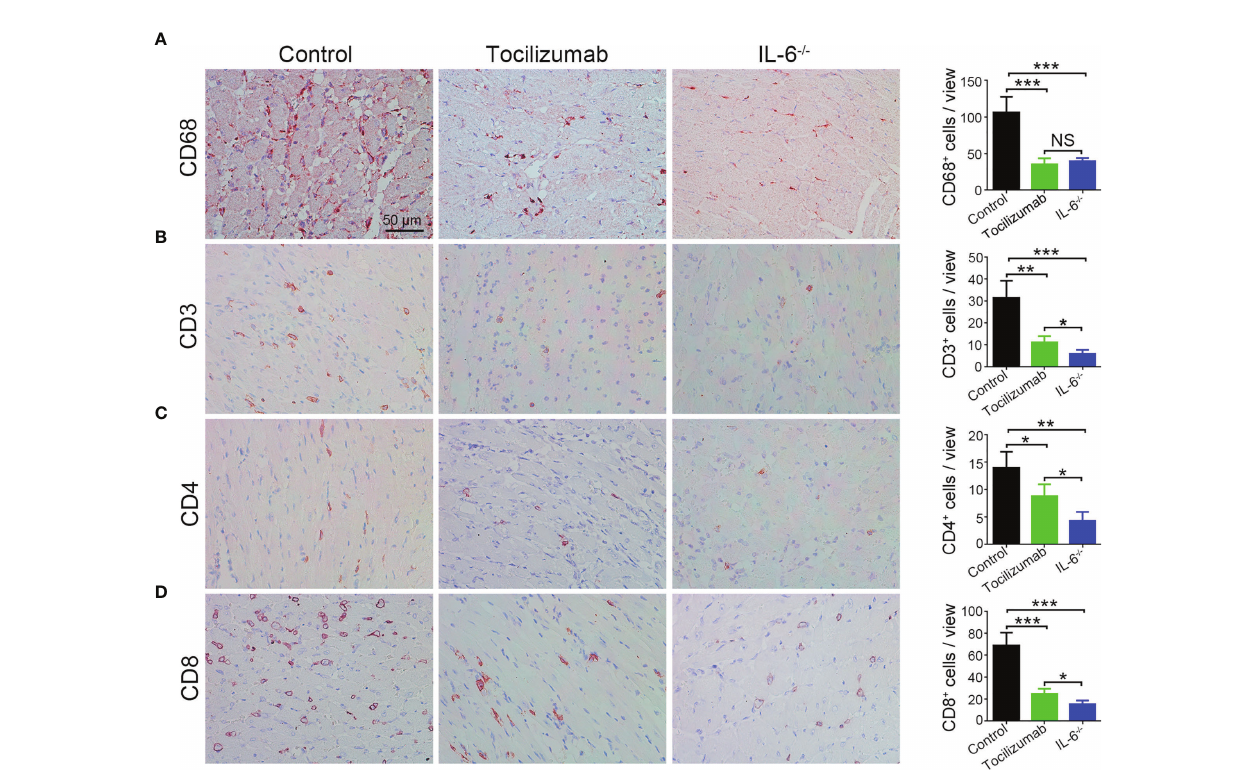
FIGURE 6 | Blockade of IL-6/IL-6R signaling reduces macrophages and T cells in fi ltration in allografts detected by immunohistochemistry staining. Representative images and quantitative analysis of CD68 (A) , CD3 (B) , CD4 (C) , and CD8 (D) in the control, tocilizumab, and IL-6 -/- groups (n = 4/group). *P<0.05; **P<0.01; ***P<0.001; NS, no signi fi